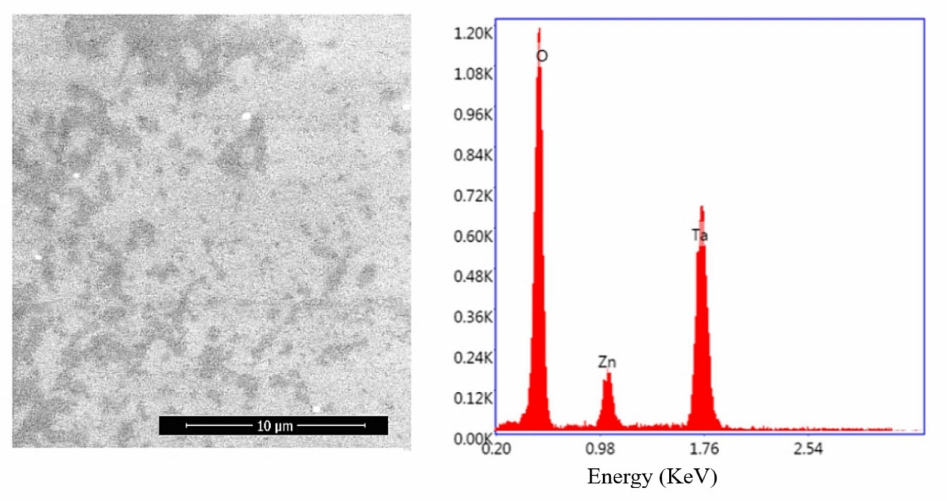
Figure 2. SEM/EDS images of 50%ZnO50%Ta 2 O 5 film deposited on borosilicate glass. The images of the film at a magnification of 10,000 × show a glassy aspect of the surface, without particles. The images show darker areas—probably richer in tantalum oxide—and lighter areas—probably higher in zinc oxide.